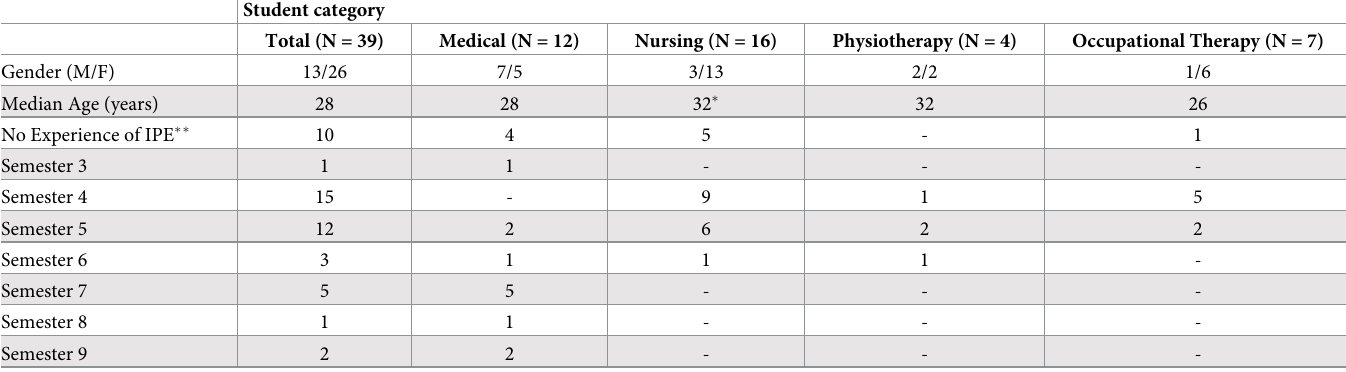
Table 1. The participating students in the study grouped according to profession, gender, age, experiences of IPE, and the semester they were